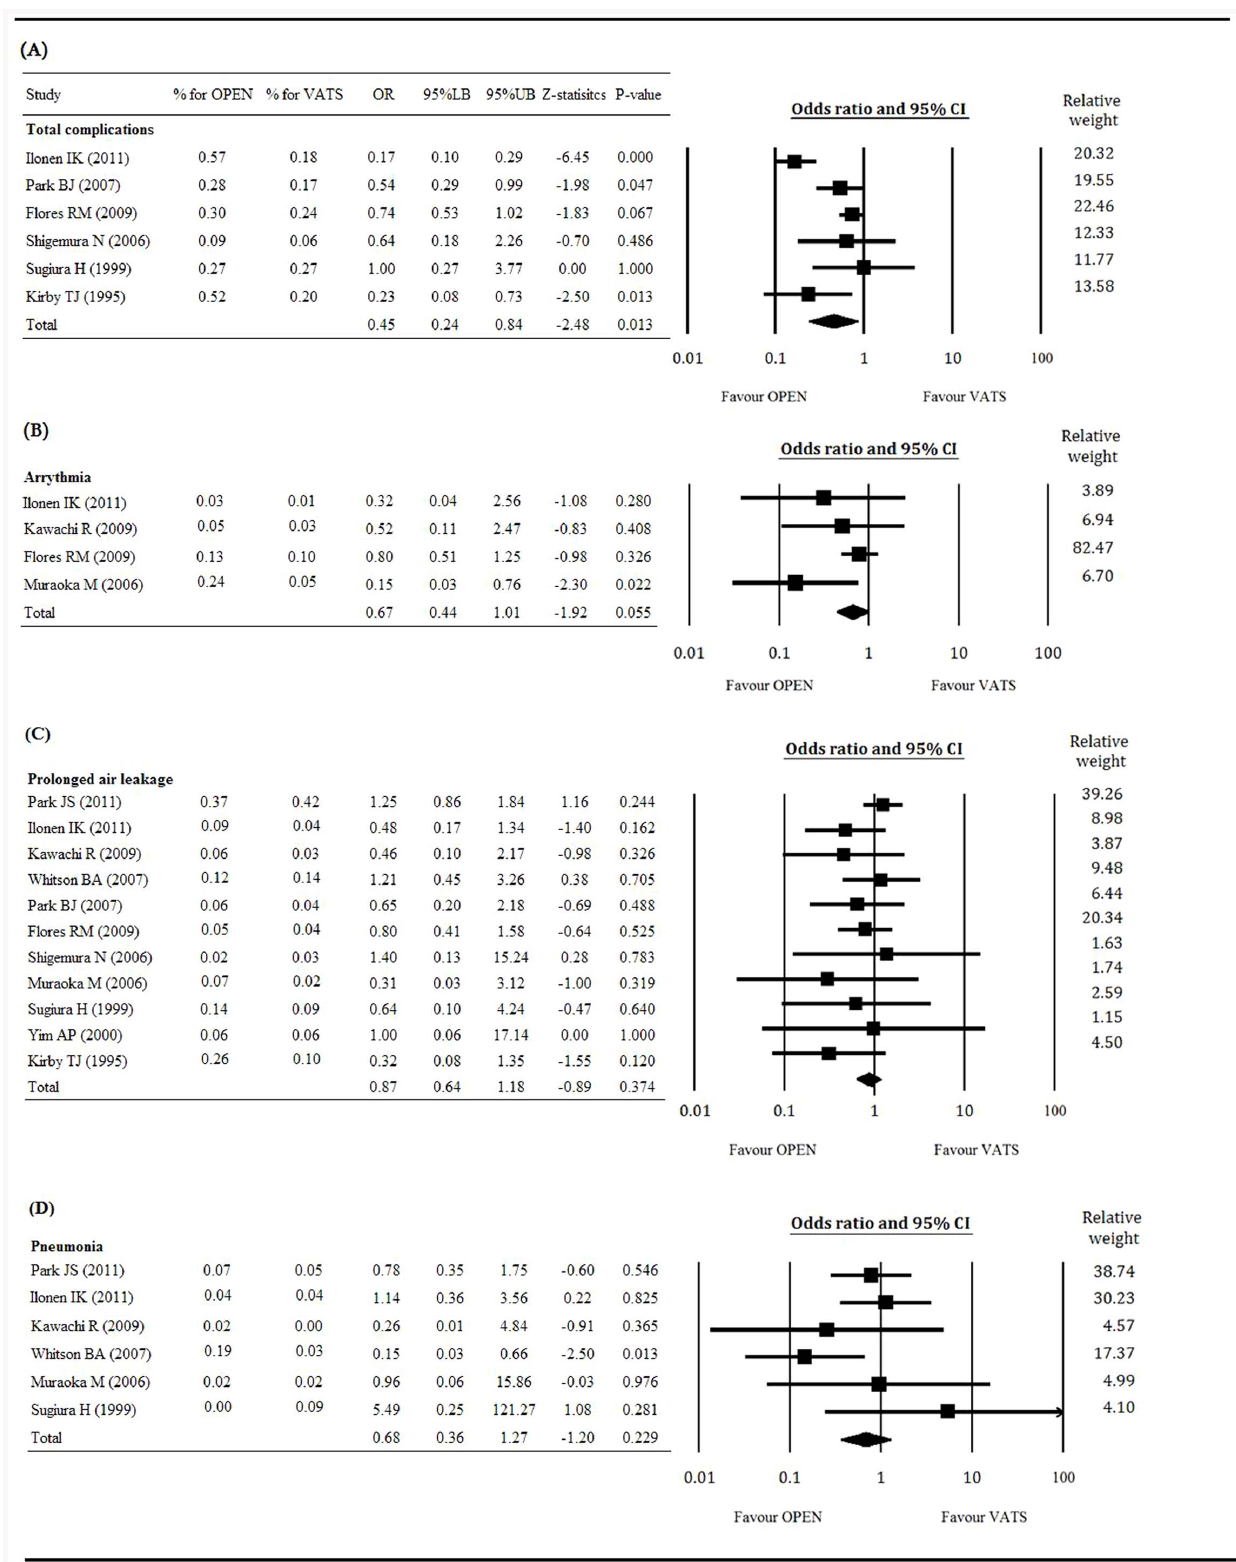
Figure 5. Forest plot for the VATS vs. open surgery groups. (A) total complications, (B) arrhythmias, (C) prolonged air leakage, and (D) pneumonia. OR, odd ratio; LB, lower boundary; UB, upper boundary; CI, confidence interval.